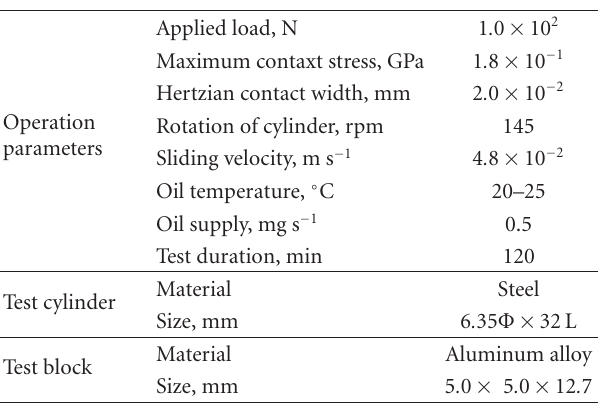
Table 3: Conditions for